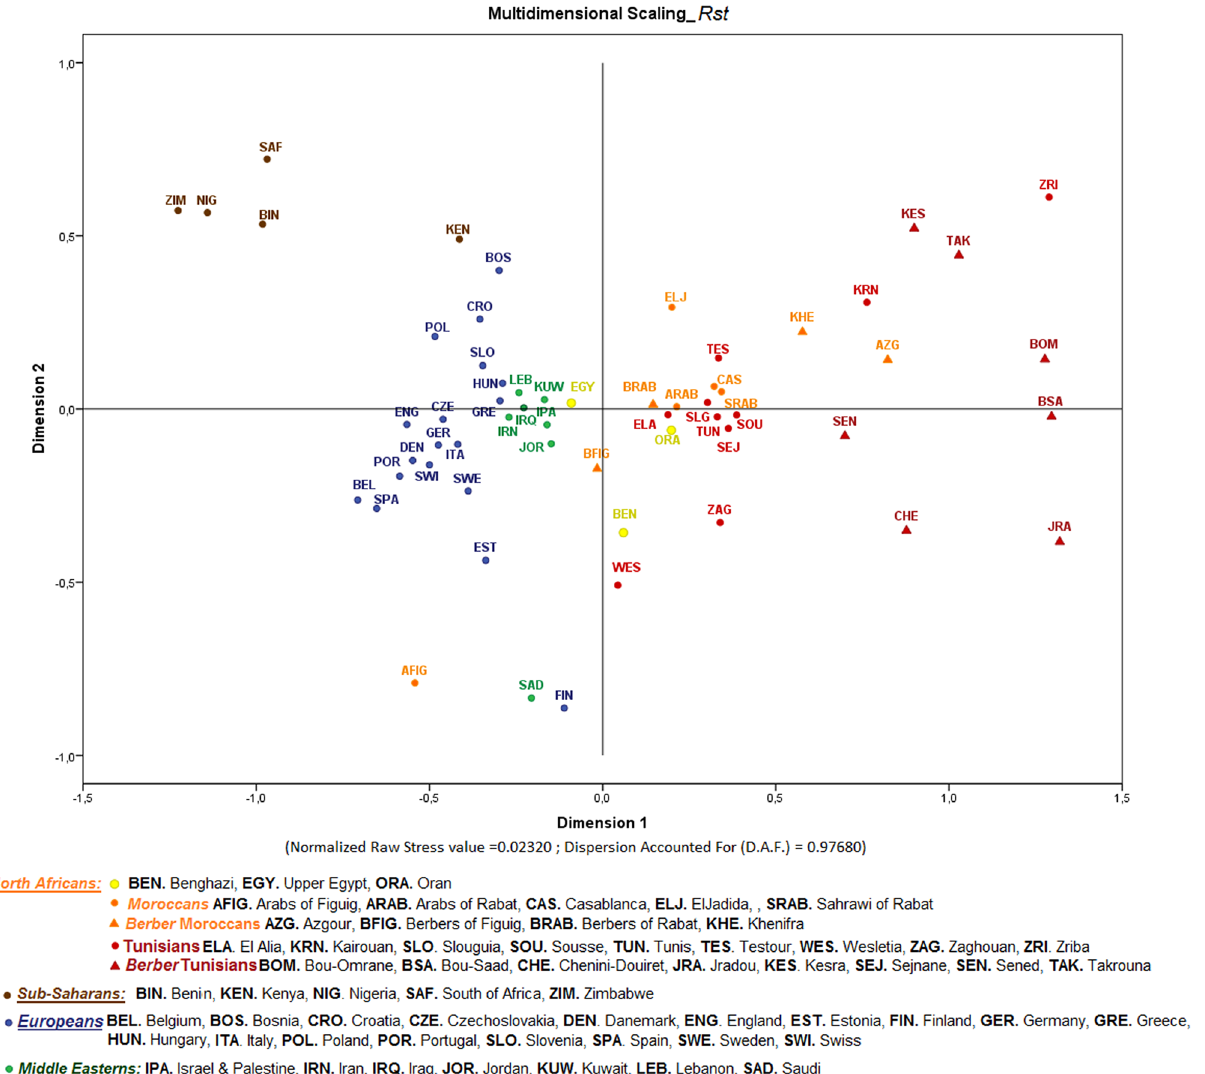
Figure. 2. Multidimensional scaling plot based on R ST genetic distances between pairs of 59 worldwide populations (references of populations in Supporting Information Table